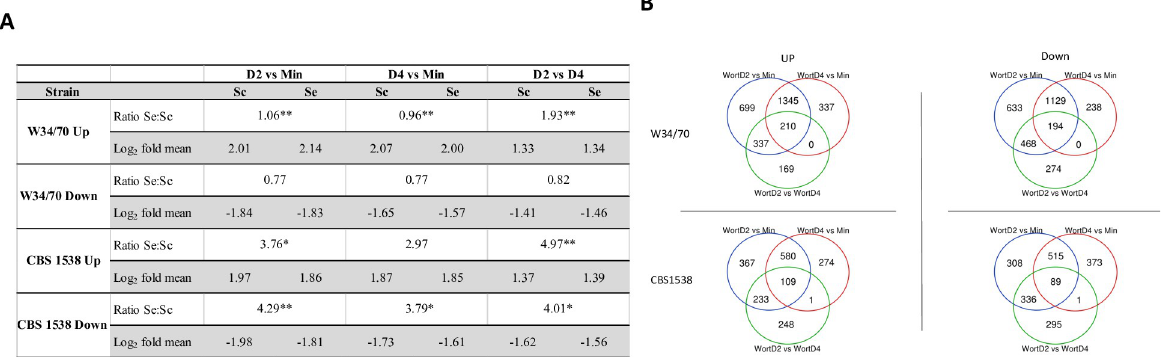
Fig 3. Ratio of S . cerevisiae (Sc) and S . eubayanus (Se) in differentially up-regulated and down-regulated transcript pools (log 2 -fold change � 1 or � -1) and mean log 2 -fold changes under the three conditions compared in CBS1538 and W34/70. A. Ratios of differentially expressed Se:Sc genes with significant differences from the expected are shown with an asterisk, p � 0.001 �� , p � 0.05 � . B. Venn diagrams showing the relationship of differentially up-regulated and down-regulated transcript pools under the comparisons of the three conditions shown.